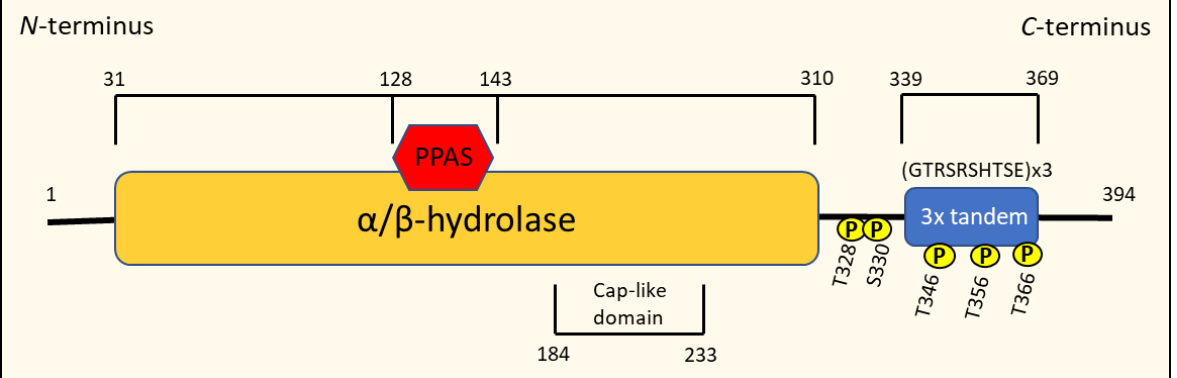
Figure 7. Schematic representation of the structure of the N-myc downstream-regulated gene 1 (NDRG1) protein.